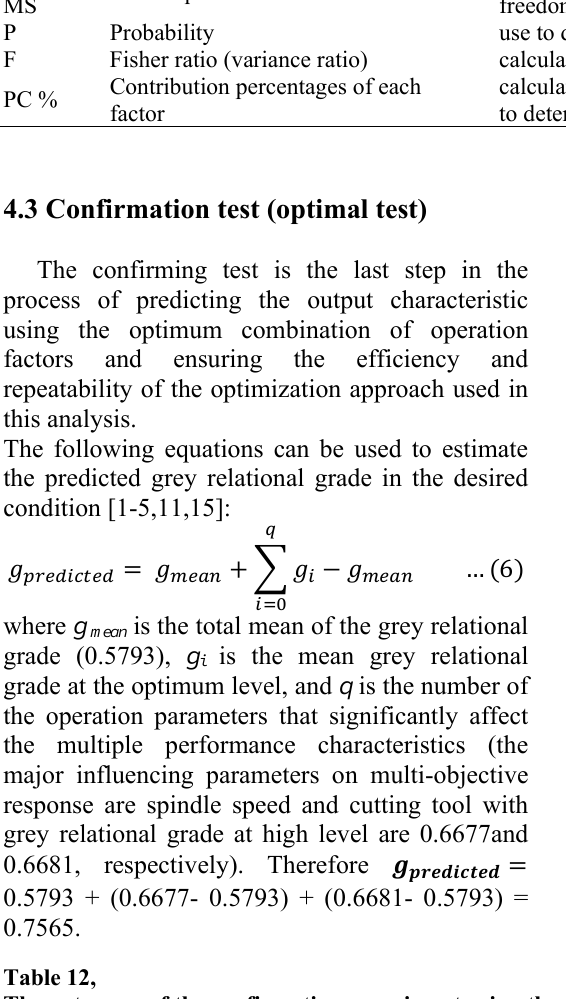
The symbols and description found in Analysis of Variance. symbol meaning description DF Degrees of freedom from each factor If a factor has three levels, the degrees of freedom is 2 (n-1) The sum of squares between groups (factor) and the sum of SS Sum of squares squares within groups (error) Can be found by dividing the sum of squares by the degrees of Mean squares freedom Probability use to determine whether a factor is significant calculated by dividing the factor MS by the MS error